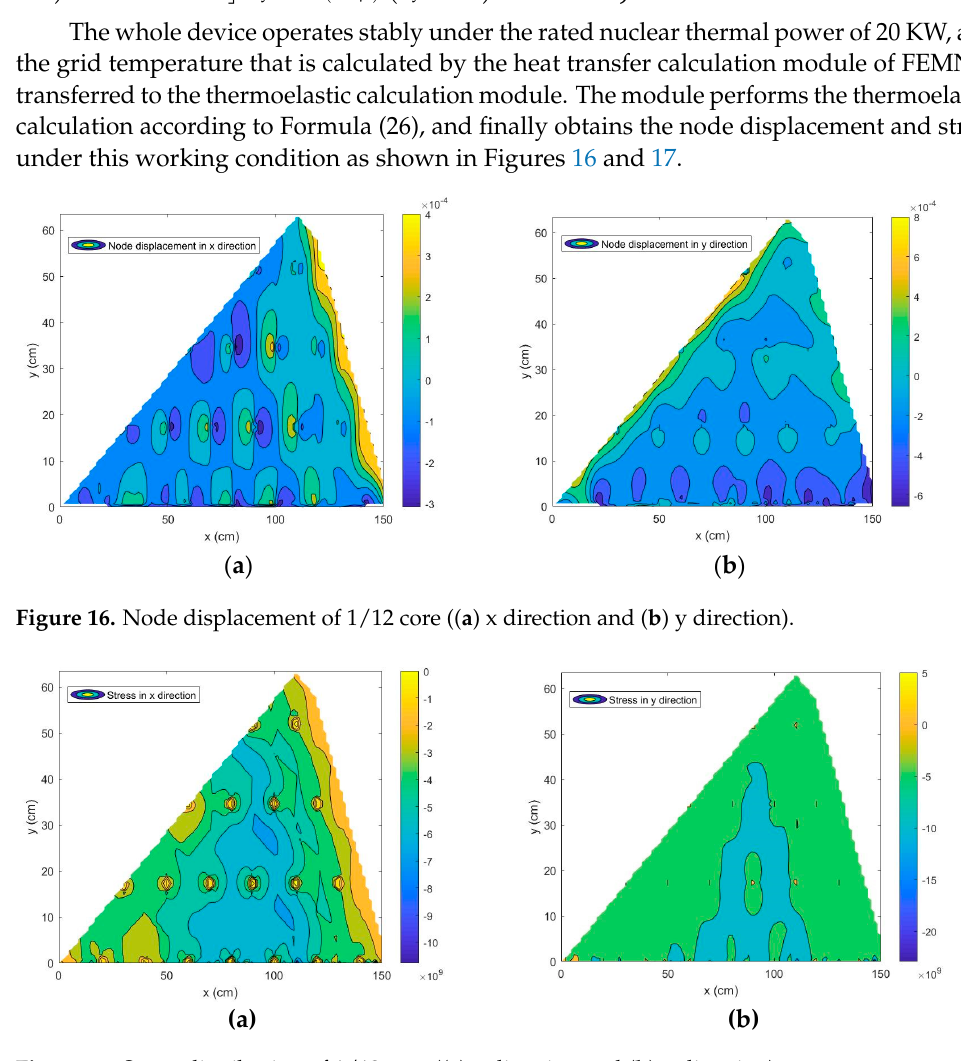
Figure 17. Stress distribution of 1/12 core (( a ) X direction and ( b ) Y